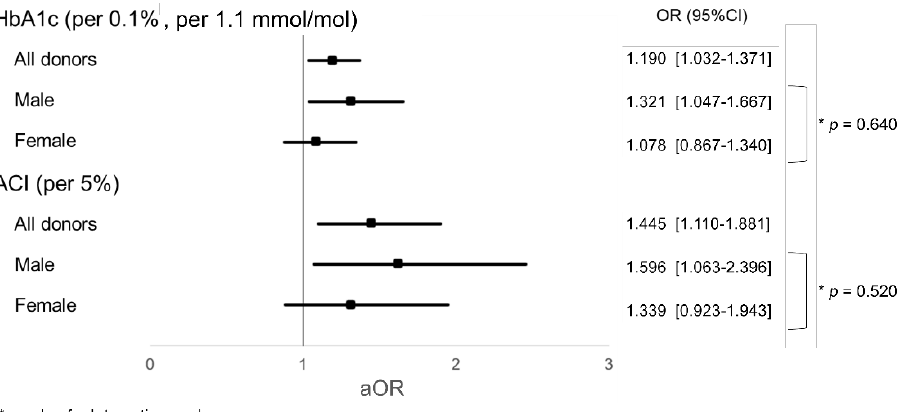
Figure2. InteractionanalysesforHbA1candACI.HbA1chemoglobinA1c. ACI:abdominalcalcification Figure 2. Interaction analyses for HbA1c and ACI. HbA1c hemoglobin A1c. ACI: abdominal index. aOR: adjusted odds calcification index. aOR: adjusted odds ratio.